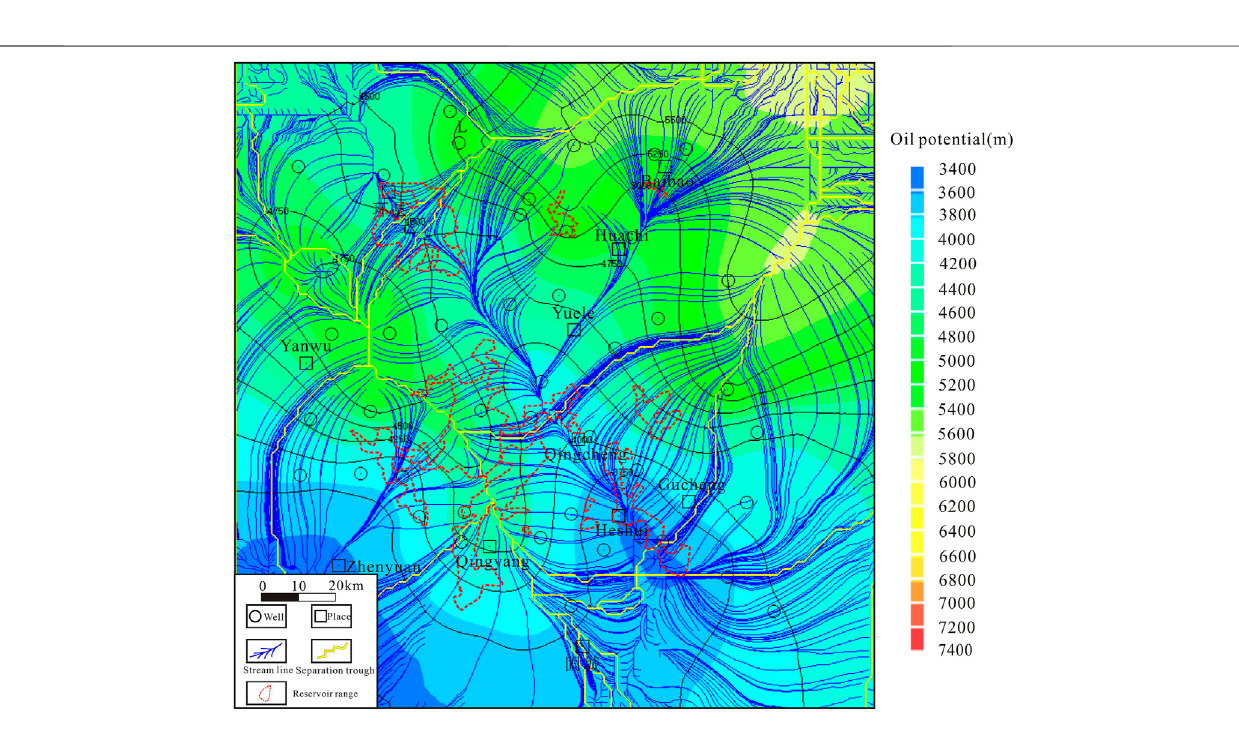
Frontiers in Earth Science |